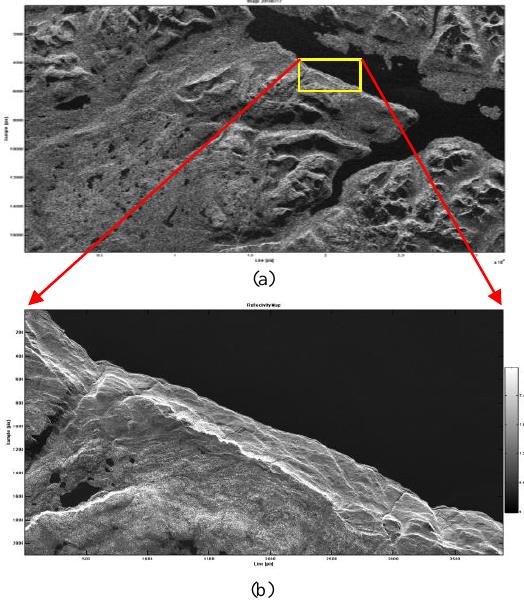
Figure 2 The reflectivity map (a) Complete Image (b) of Study Region The geographical extent of dataset shown in image (a) covers area of 50 km x 30 km